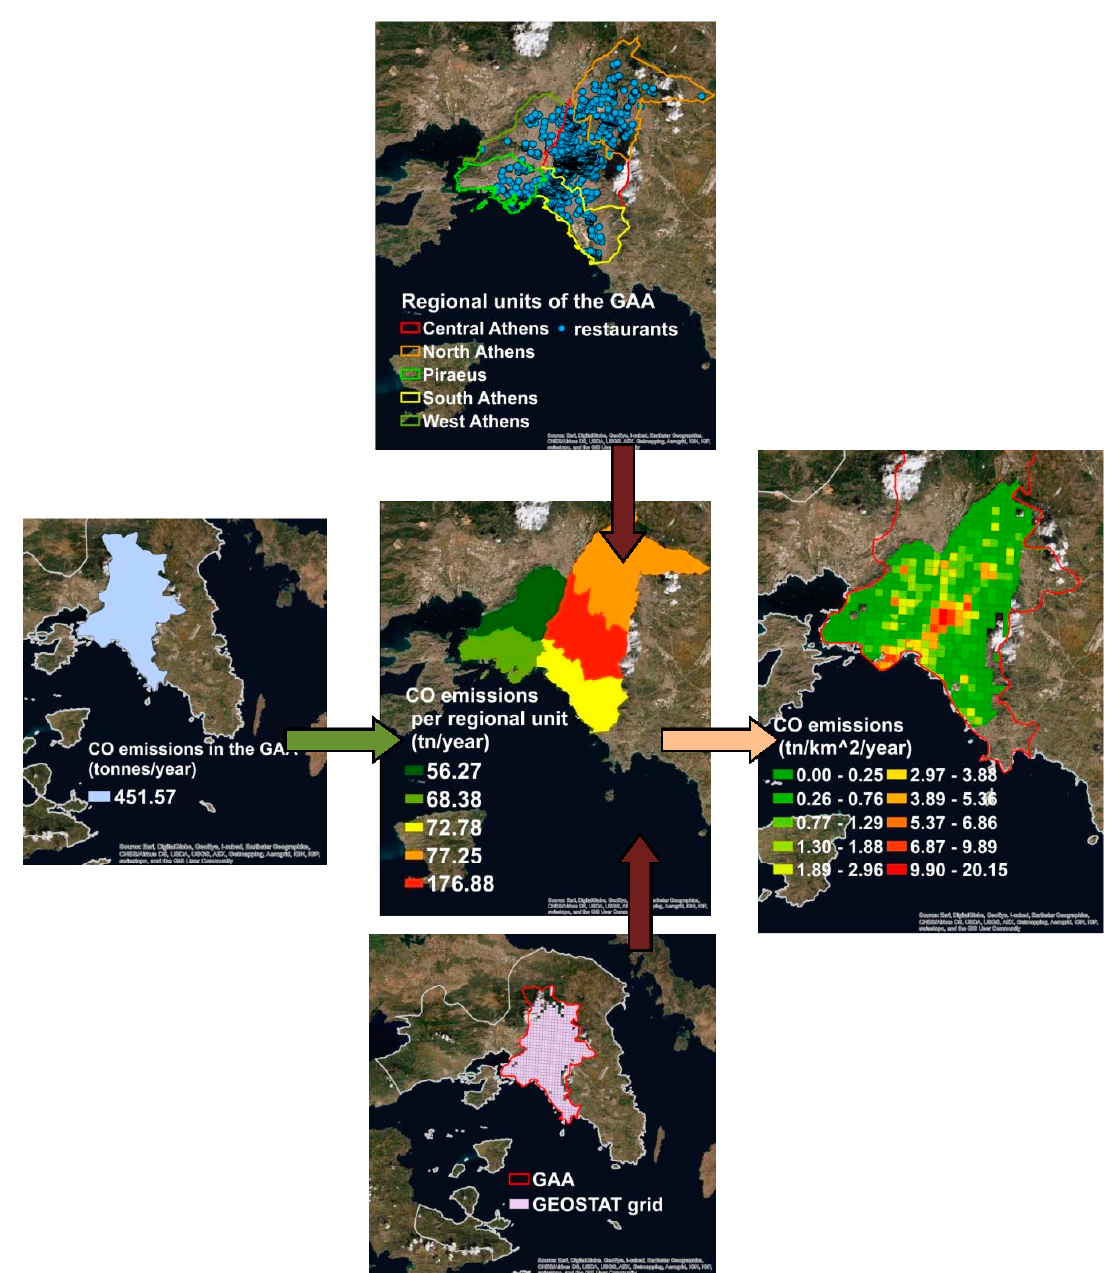
Figure 2. Methodology for the spatial allocation of emissions for the GAA to gridded values (1 × 1 km 2